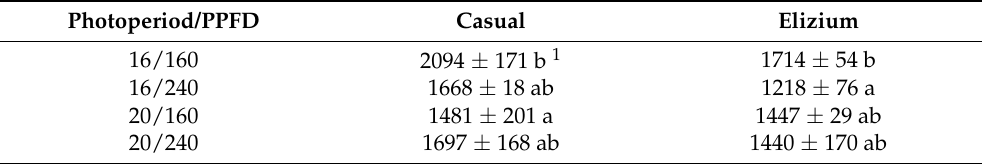
Table 1. Concentrations of nitrate nitrogen (mg kg − 1 f.w.) in the leaves of cv. ‘Casual’ and cv. ‘Elizium’ romaine lettuce grown under different light environments (photoperiod 16 and 20 h and PPFD 160 and 240 µ mol m − 2 s − 1 ). Bars represent means ± SE. Means followed by the same letter are not significantly different ( p < 0.05) according to Tukey’s HSD test.